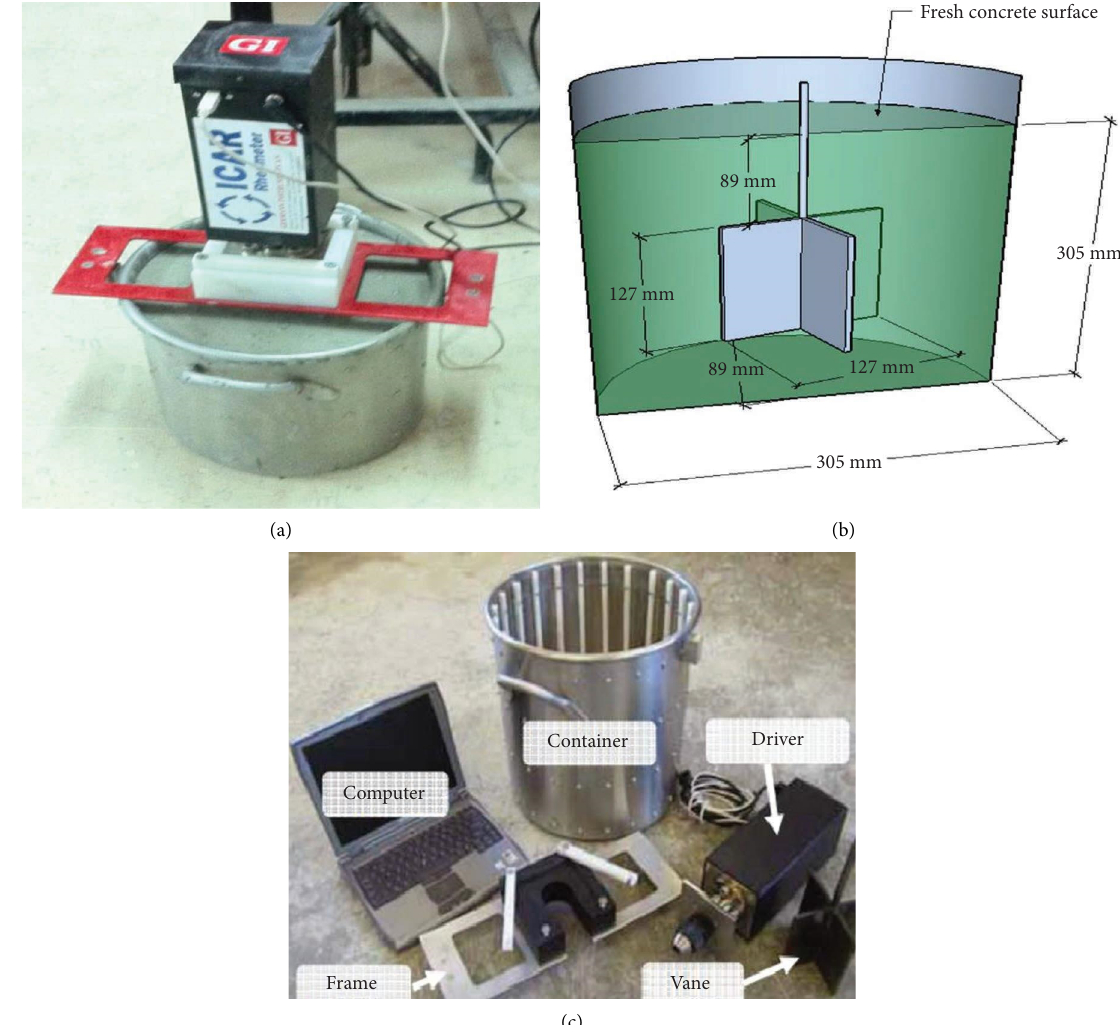
Figure 3: View of (a) a rheometer, (b) a detailed schematic representation, and (c) an ICAR device with its accessories.